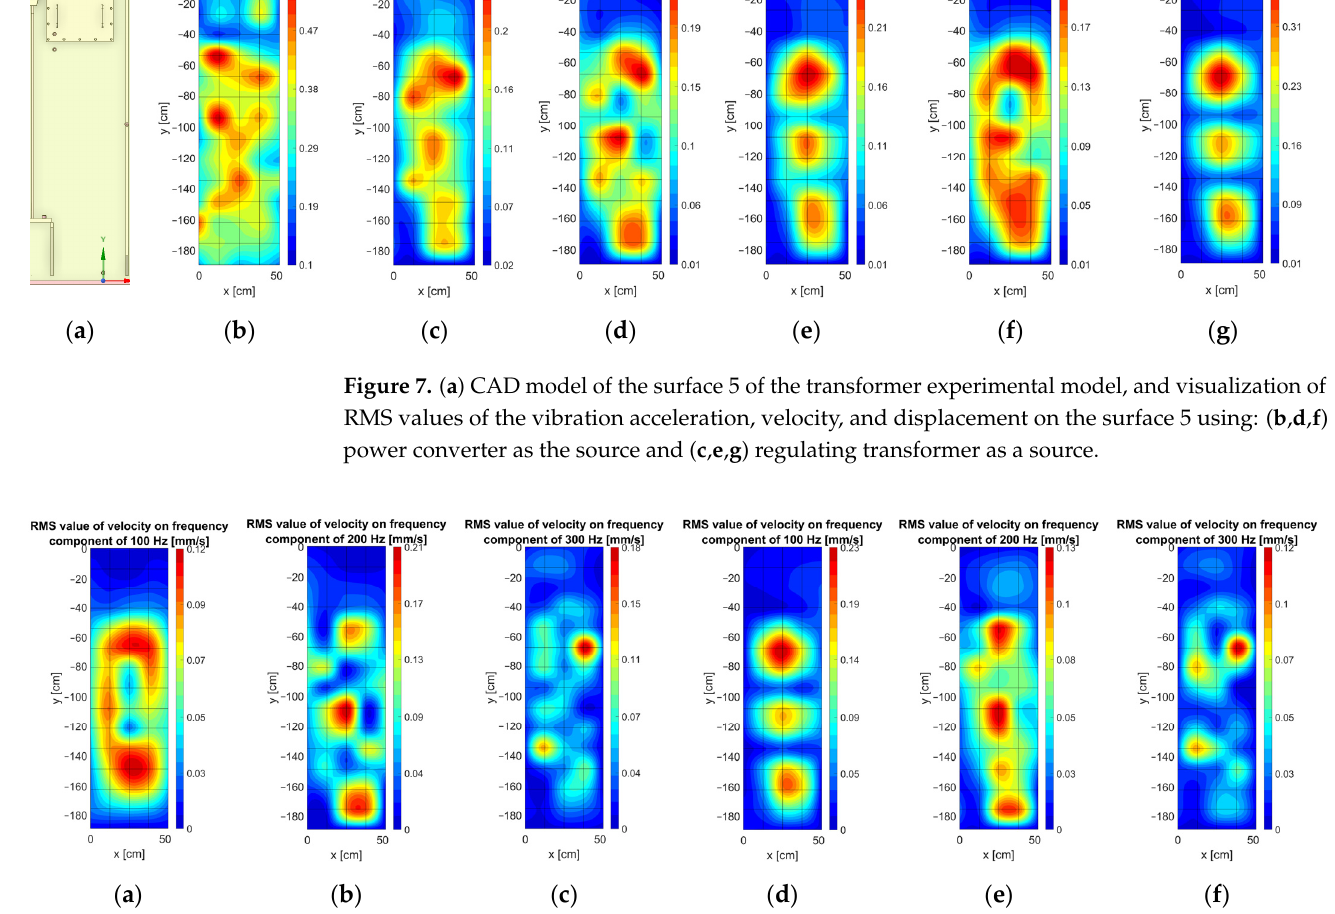
Figure 7. ( a ) CAD model of the surface 5 of the transformer experimental model, and visualization of RMS values of the vibration acceleration, velocity, and displacement on the surface 5 using: ( b , d , f ) power converter as the source and ( c , e , g ) regulating transformer as a source.